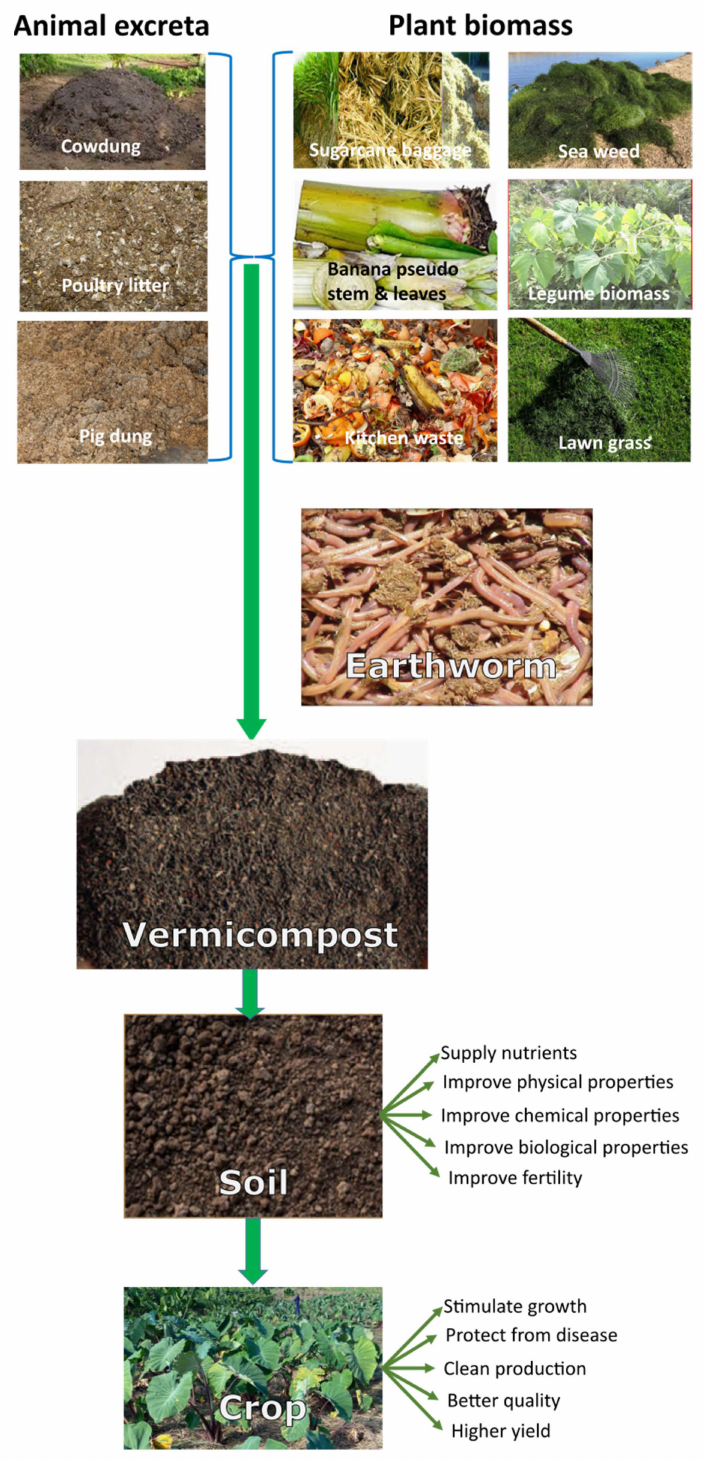
Figure 1. Schematic summary of the vermicomposting process and its beneficial effects on soil health and crop productivity (Adapted from Chatterjee et al. (2021)